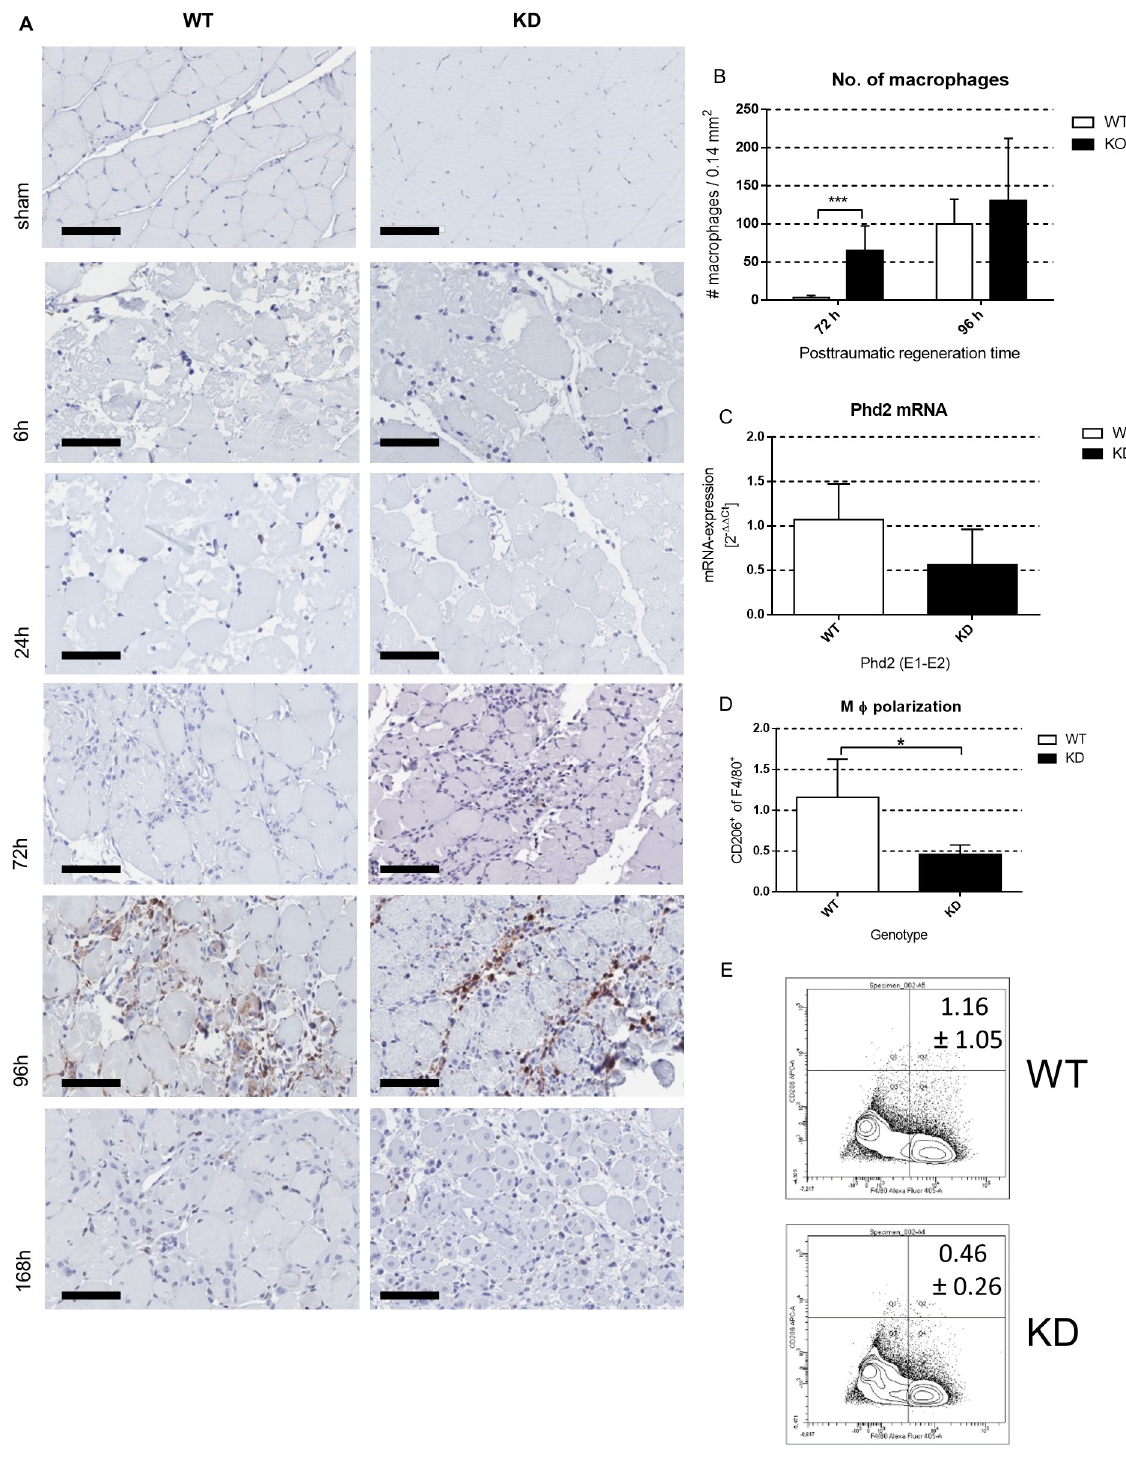
Fig 6. Macrophage recruitment to traumatic areas starts earlier in Phd2 -hypomorphic mice. (A) Immunohistochemical staining of F4/80 of traumatic and sham treated wild type (WT) and Phd2 -hypomorphic (KD) mice. Shown are slides of 1 μ m thickness (200x magnification; scale bar: 200 μ m). 72 hours after trauma, macrophage invasion is significantly higher in KD animals (B). (C) Bone marrow derived macrophages of KD mice show a 50% reduction in Phd2 Exon 1 (E1)—Exon 2 (E2) in qPCR analysis (mean ± SD; n = 5). (D) Flow cytometric analysis of bone marrow derived macrophages of WT and KD cells reveals a significantly reduced expression of the surface marker CD206, which characterizes anti-inflammatory macrophages, in KD cells (mean ± SD; n = 5). (E) Gating strategy of F4/80 + CD206 + bone marrow derived macrophages from WT and KD animals. Mean percentages ( ± SD; n = 5) of this population are indicated in the upper right corner � P < 0.05, ��� P < 0.001. https://doi.org/10.1371/journal.pone.0233261.g006 PLOS ONE | https://doi.org/10.1371/journal.pone.0233261 May 15,